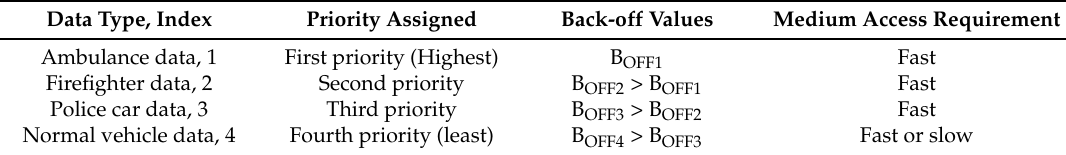
Table 2. Data types with priority assignment and access requirements.